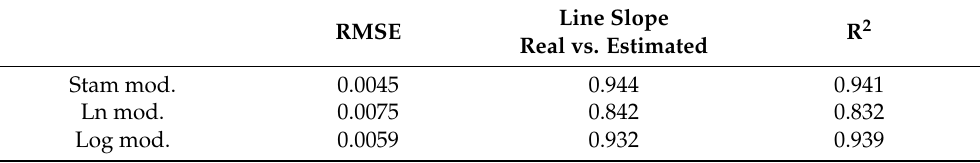
Table 5. Statistical parameters to evaluate the model’s goodness of fit of ∆ m/m 0 = f( ρ ). Line Slope RMSE R 2 Real vs. Estimated Stam mod. 0.0045 0.944 0.941 Ln mod. 0.0075 0.842 0.832 Log mod.